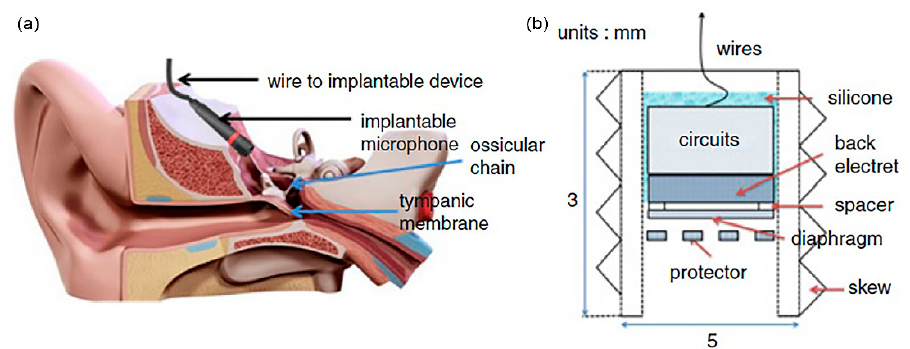
Figure 20. ( a ) The position of the implantable electrostatic-based microphone. ( b ) The block diagram of the microphone [81].